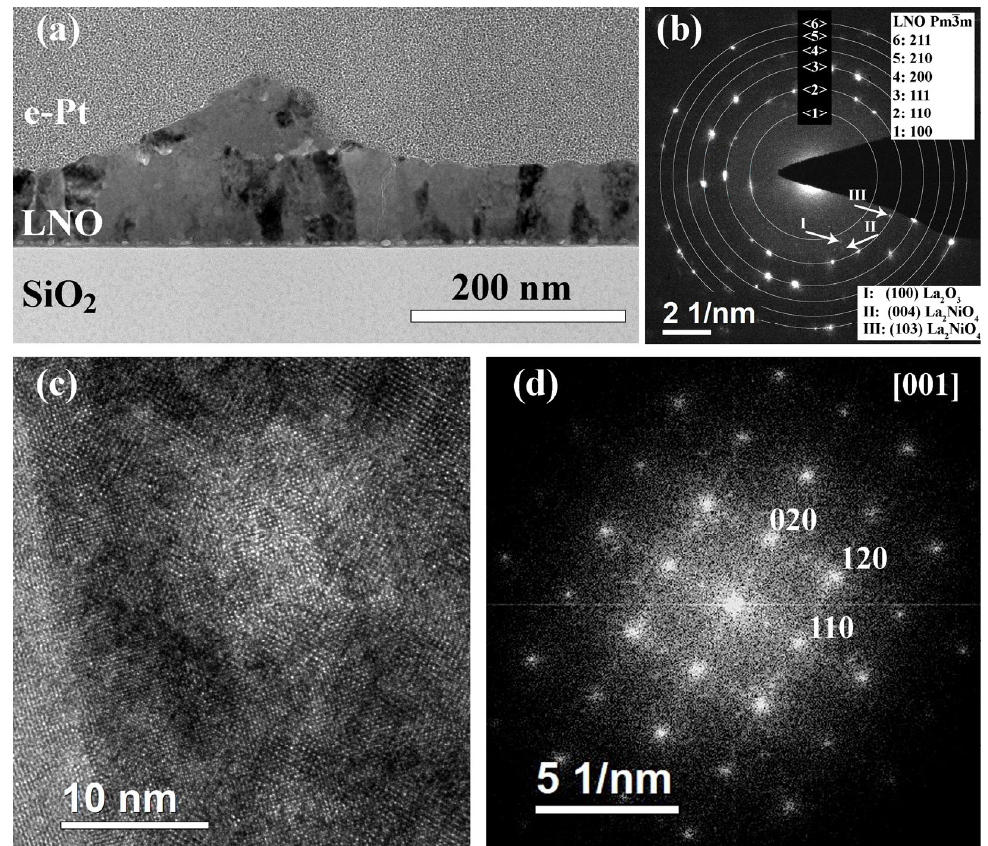
Figure 8. Structure of an LNO ‐ cryst ‐ 10 min sample: BF TEM image ( a ), SAED pattern ( b ), HRTEM image ( c ), and the corresponding Fourier diffraction pattern ( d ).